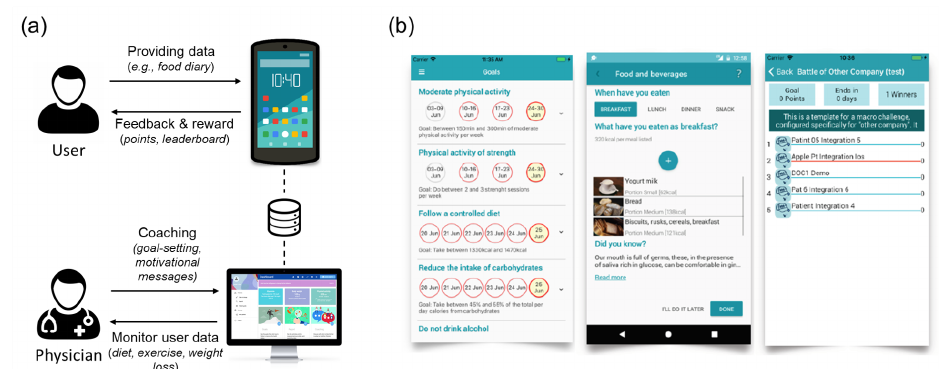
Figure 1. Overview of the design of DMCoach+. ( a ) System architecture; ( b ) Screenshots (left: goals and progress; middle: food diary input; right: leaderboard of the social